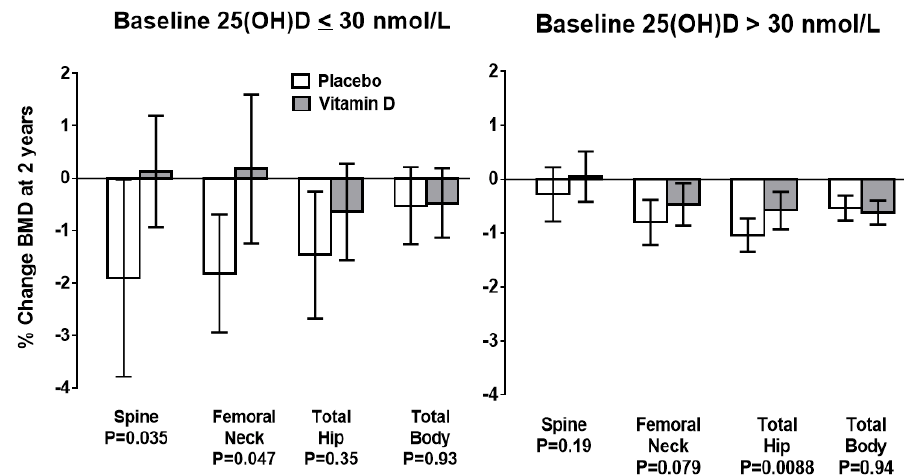
Figure 2. Changes in bone mineral density (BMD) from baseline to 2 years in the vitamin D and placebo groups of the ViDA Study, grouped according to baseline serum 25-hydroxyvitamin D (25(OH)D) concentrations. Data are mean ± 95% confidence intervals. P values for between-groups comparisons are shown. From: Reid IR et al., Effect of monthly high-dose vitamin D on bone density in community-dwelling older adults: substudy of a randomized controlled trial. J Int Med 282: 452- 460, 2017 [24]. Used with permission.